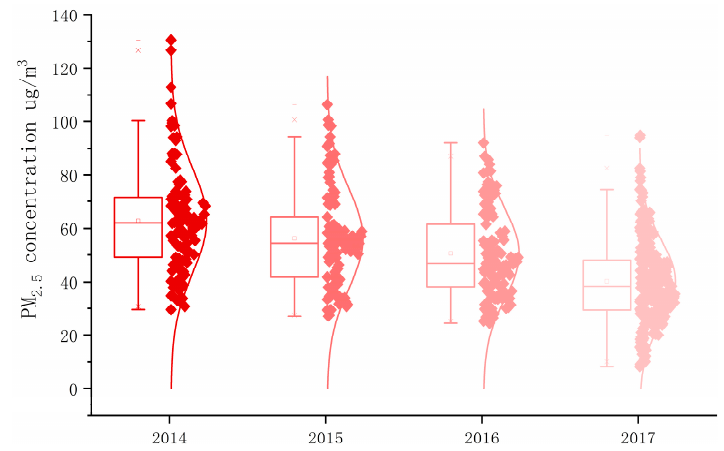
Figure 1. PM 2.5 concentration value box line normal curve from 2014 to 2017.